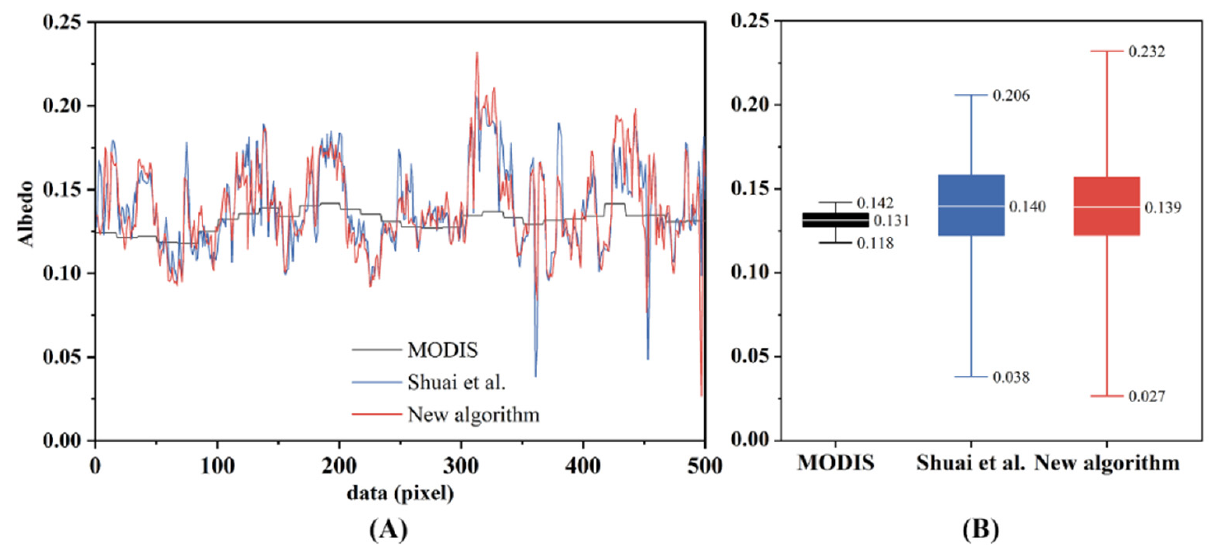
Figure 10. Comparison between the land surface albedos from the three datasets along a transect (black lines in Figure 8). ( A ): the cross-sectional view of the three products; ( B ): the boxplots of three albedo products. The whiskers represent the maximum and minimum value of statistics.